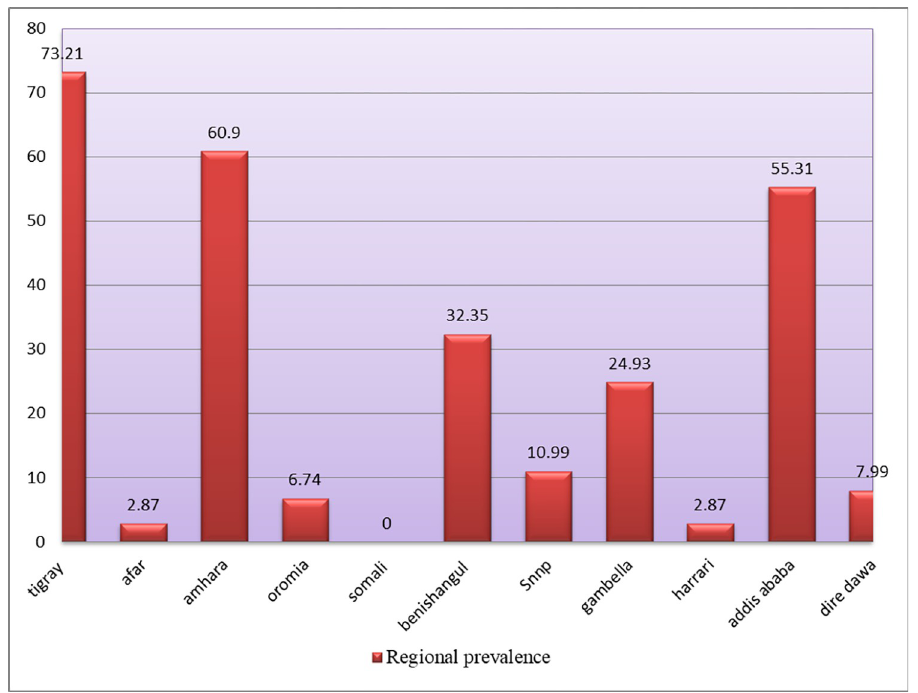
Fig 1. Regional prevalence of alcohol consumption during pregnancy in Ethiopia,